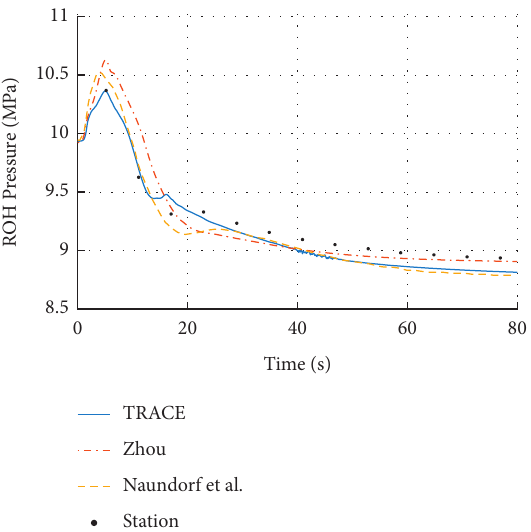
Figure 31: Reactor outlet header pressures for the loss of flow